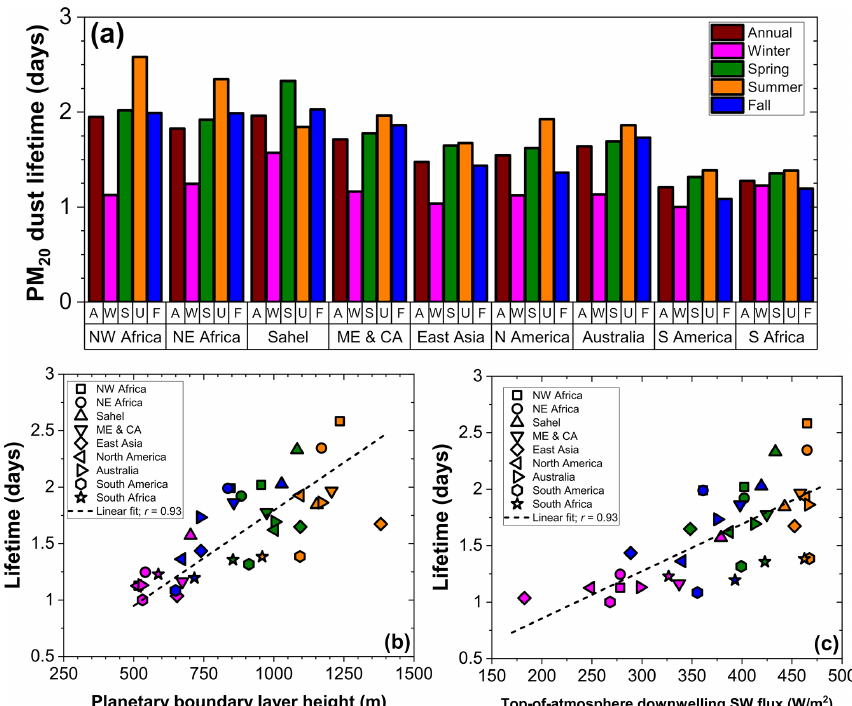
Figure 3. Seasonal variation of dust lifetime for the different source regions. (a) Mass-weighted lifetime of PM 20 dust for each source region on an annual basis (A; brown bars) and for each source region’s local winter (W), spring (S), summer (U), and fall (F) seasons (magenta, green, orange, and blue bars). Variations in dust lifetime are largely explained by differences in downwelling SW flux (panel b ) and planetary boundary layer (PBL) height (panel c ). This indicates that the increased modeled dust lifetime in spring and summer is due to increased convection, which lofts dust to greater altitudes. The colors of the symbols in panels (b) and (c) denote the season per the color scheme in panel (a) . The TOA downwelling SW flux was obtained from Wong and Chow (2001), the seasonally averaged PBL height was obtained from the GISS Model E2.1 simulation (Kelley et al., 2020), and the mass-weighted dust lifetimes were obtained from the ratio of the PM 20 dust loading to the deposition flux for each source region and season. Size-resolved annual and seasonal dust lifetimes of the individual model ensemble simulations used in the inverse model are shown in Figs.